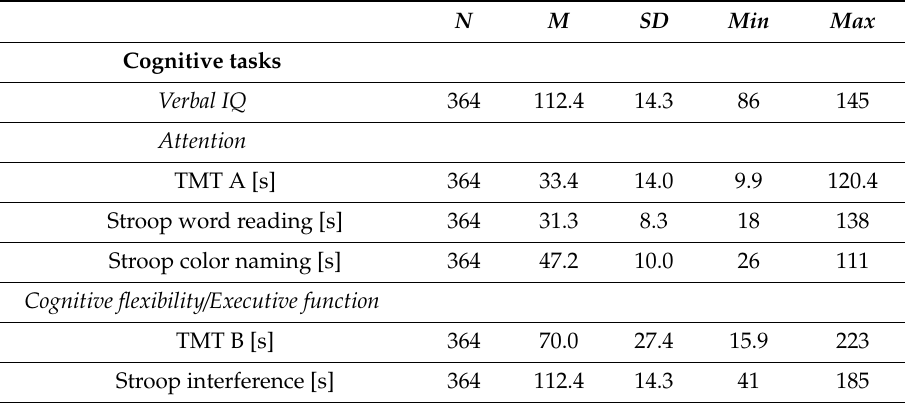
Table 2. Cognitive test scores (mean, standard deviations, minimum,